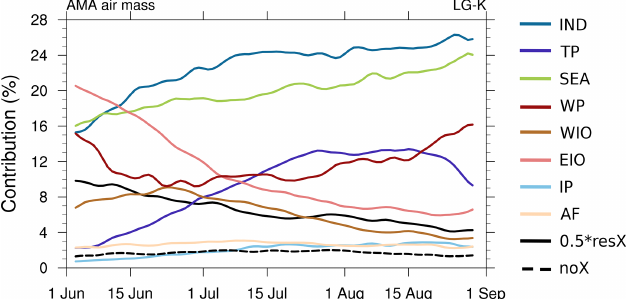
Figure B4. Source evolution in the LG-K data during 1981 to 2010 (with 2008 removed; see text for details). resX data have been scaled by 0.5. All contributions have been smoothed using 5d running means (weights of summing up the 10-hourly data for each